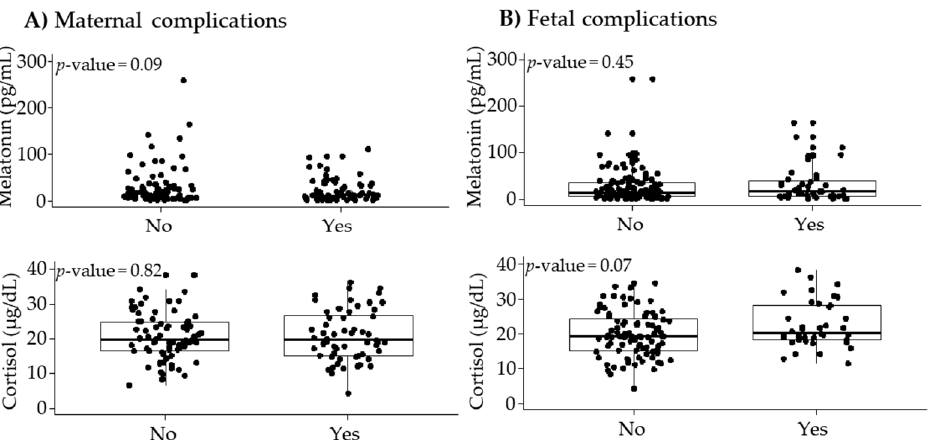
Figure 2. Maternal plasma melatonin and cortisol levels according to maternal ( A ) and fetal ( B ) complications. Data show median and interquartile range (IQR). The p -value was obtained by Mann–Whitney U test.